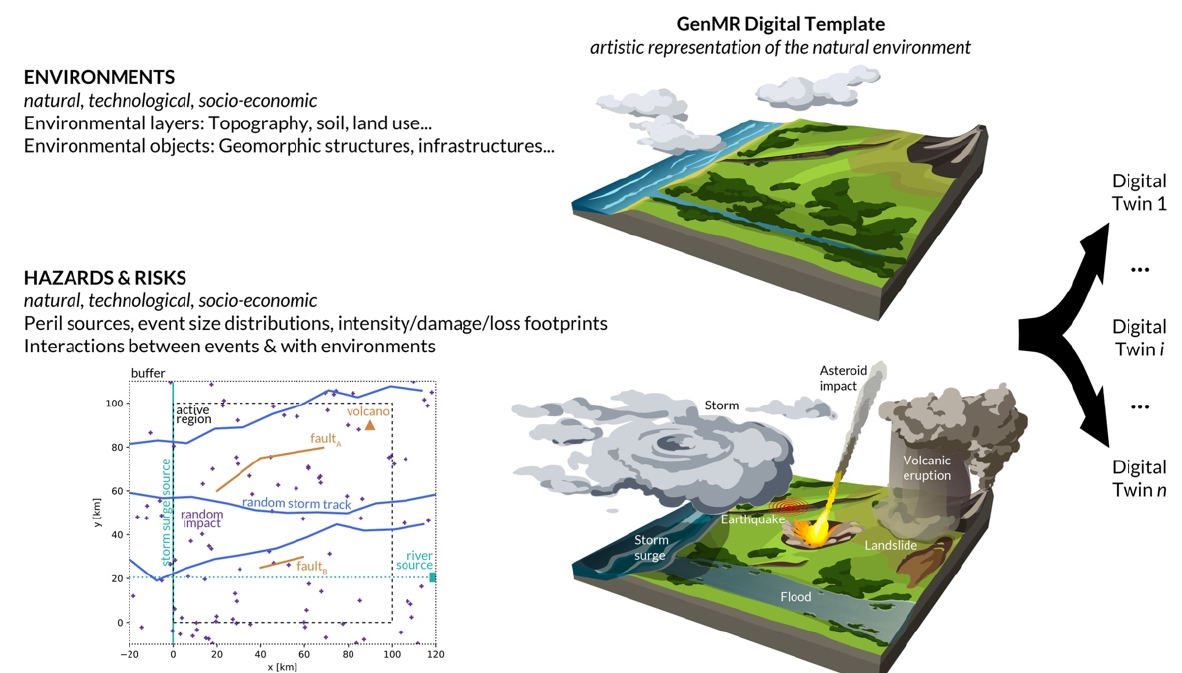
Figure 1. Concept of digital template in the context of the Generic Multi ‐ Risk (GenMR) framework. The version defined in the present article consists of two natural environmental layers (topography and soil) and of some geomorphic structures, as well as of the hazard intensity footprints of the following perils, in alphabetic order: asteroid impacts (AI), earthquakes (EQ), landslides (LS), river floods (RF), storm surges (SS), volcanic eruptions (VE), and windstorms (WS)—For a simplified, earlier version originally coined virtual city, see [3,5,20]. Both previous and new versions are based on an original sketch drawn by the author during the MATRIX project. Peril source locations for the default parameterization (Table A2) are shown on the left map.